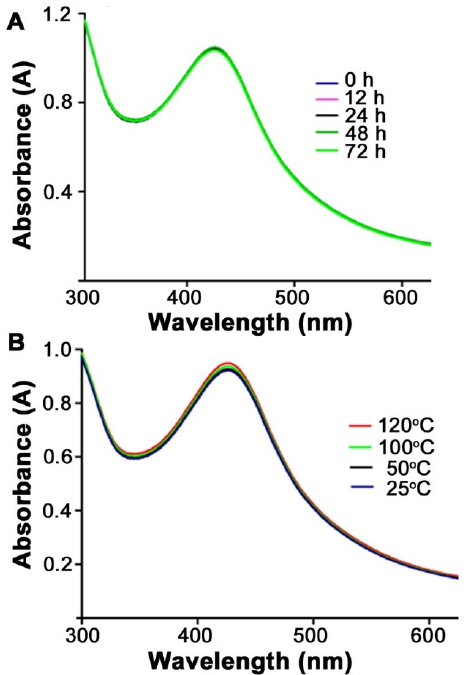
Figure 3. ( A ) Storage and ( B ) heat stability studies of the synthesized Chi-AgNPs.